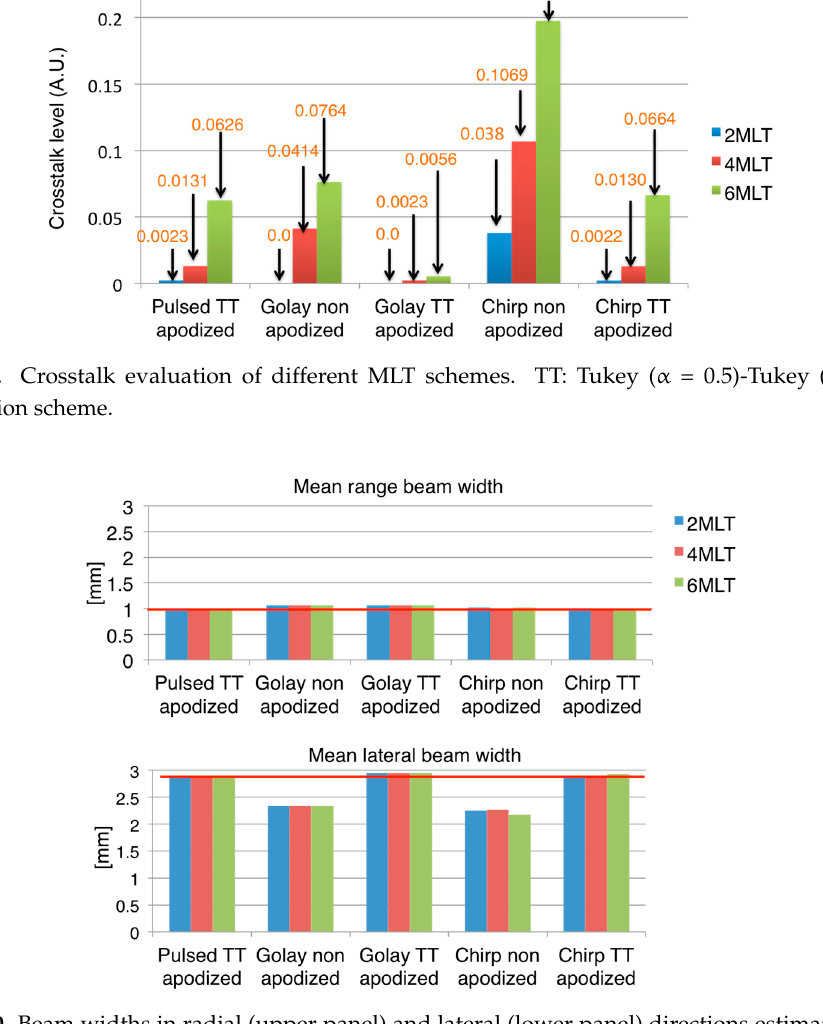
Figure 10. Beam widths in radial (upper panel) and lateral (lower panel) directions estimated from the point-spread-function (PSF). The red line indicates the value of a non-coded SLT scheme using TT apodization. TT: Tukey ( α = 0.5)-Tukey ( α = 0.5) apodization scheme.